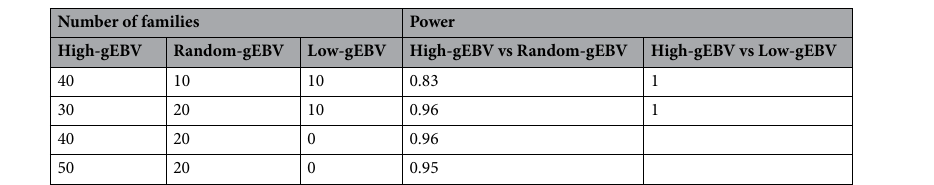
Table 2. Power of experiment to evaluate genomic selection assuming one male is mated with one female to generate each separate